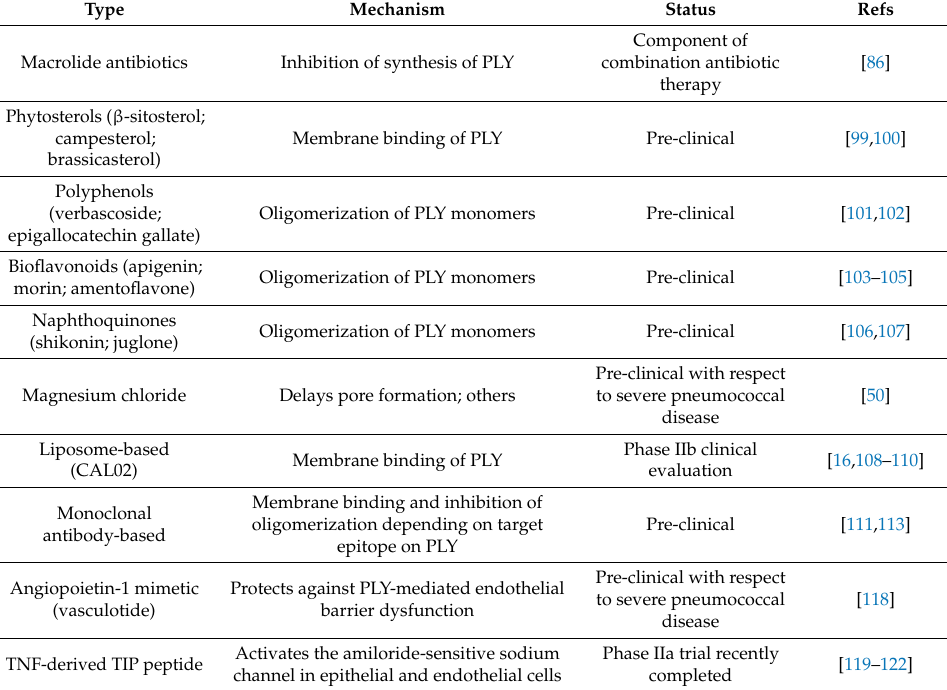
Table 1. Recognized and potential pneumolysin (PLY)-targeted therapeutic